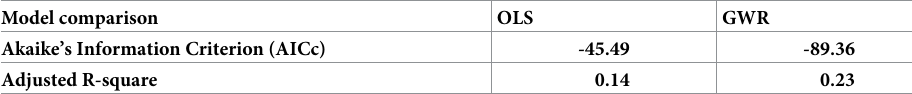
Table 3. Model comparison of OLS and GWR model.